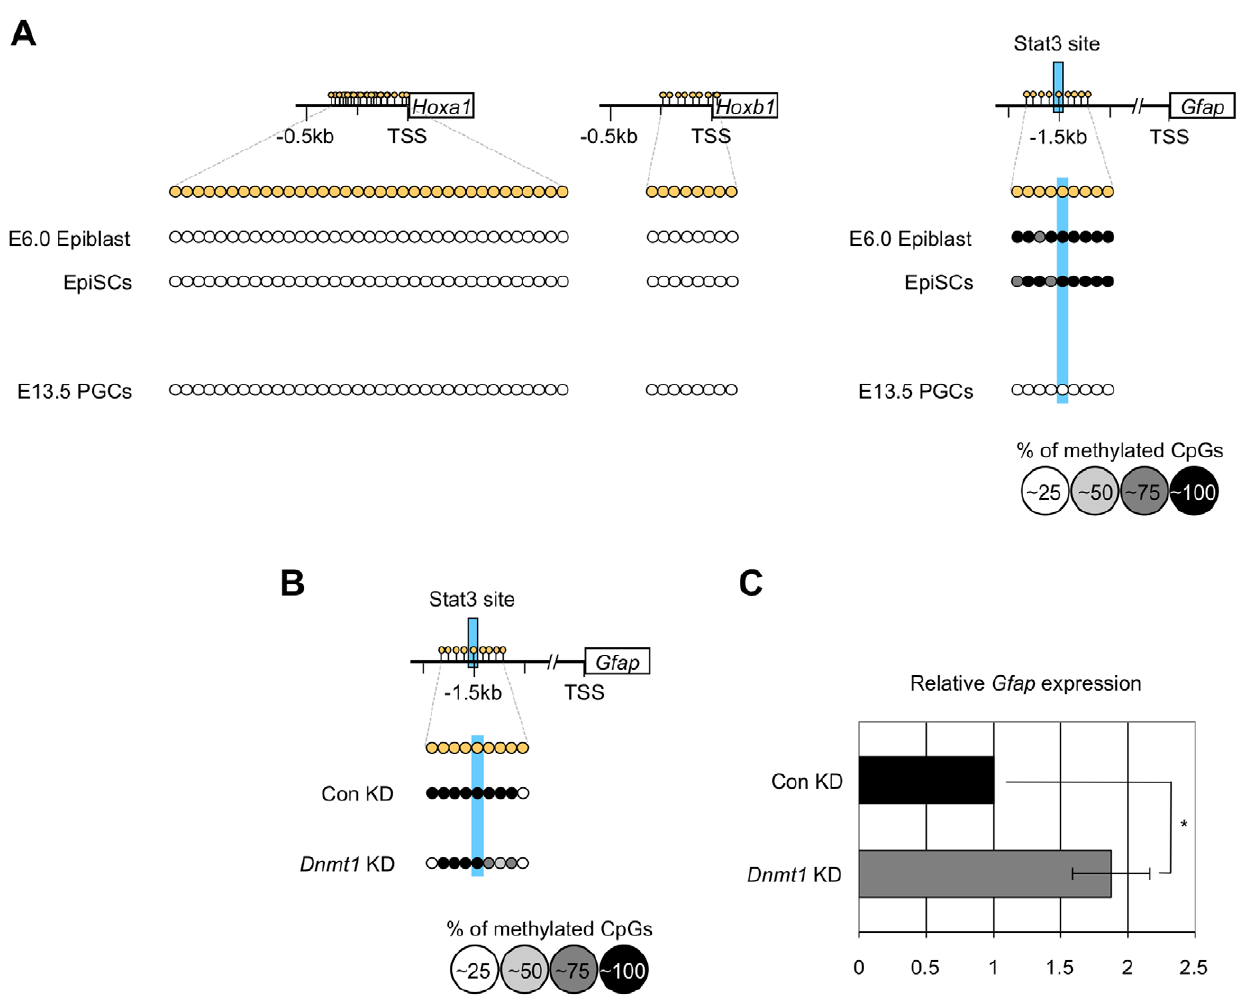
Figure 7. Repression of somatic gene expression does not depend on DNA methylation in PGCs. (A) Bisulfite sequencing analysis of the flanking regions of Hoxa1 , Hoxb1 , and Gfap was performed using epiblasts (E6.0), epiblast stem cells (EpiSCs), and PGCs (E13.5), showing hypomethylation in PGCs. (B) Bisulfite sequencing analysis of the regulatory region of Gfap and (C) quantitative RT-PCR analysis of the Gfap expression were performed using ES cells with or without Dnmt1 knockdown treatment ( Dnmt1 KD/Con